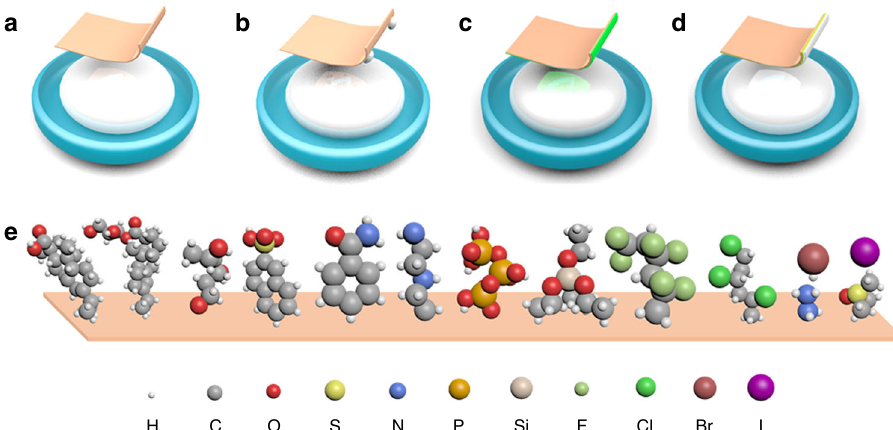
Fig. 1 Schematic of an ultrathin Li layer formed onto lithiophobic substrates. Contact schematic of molten Li and the Cu substrate without ( a , b ) and with ( c , d ) the functional coating. e Molecular structures of various functional coatings